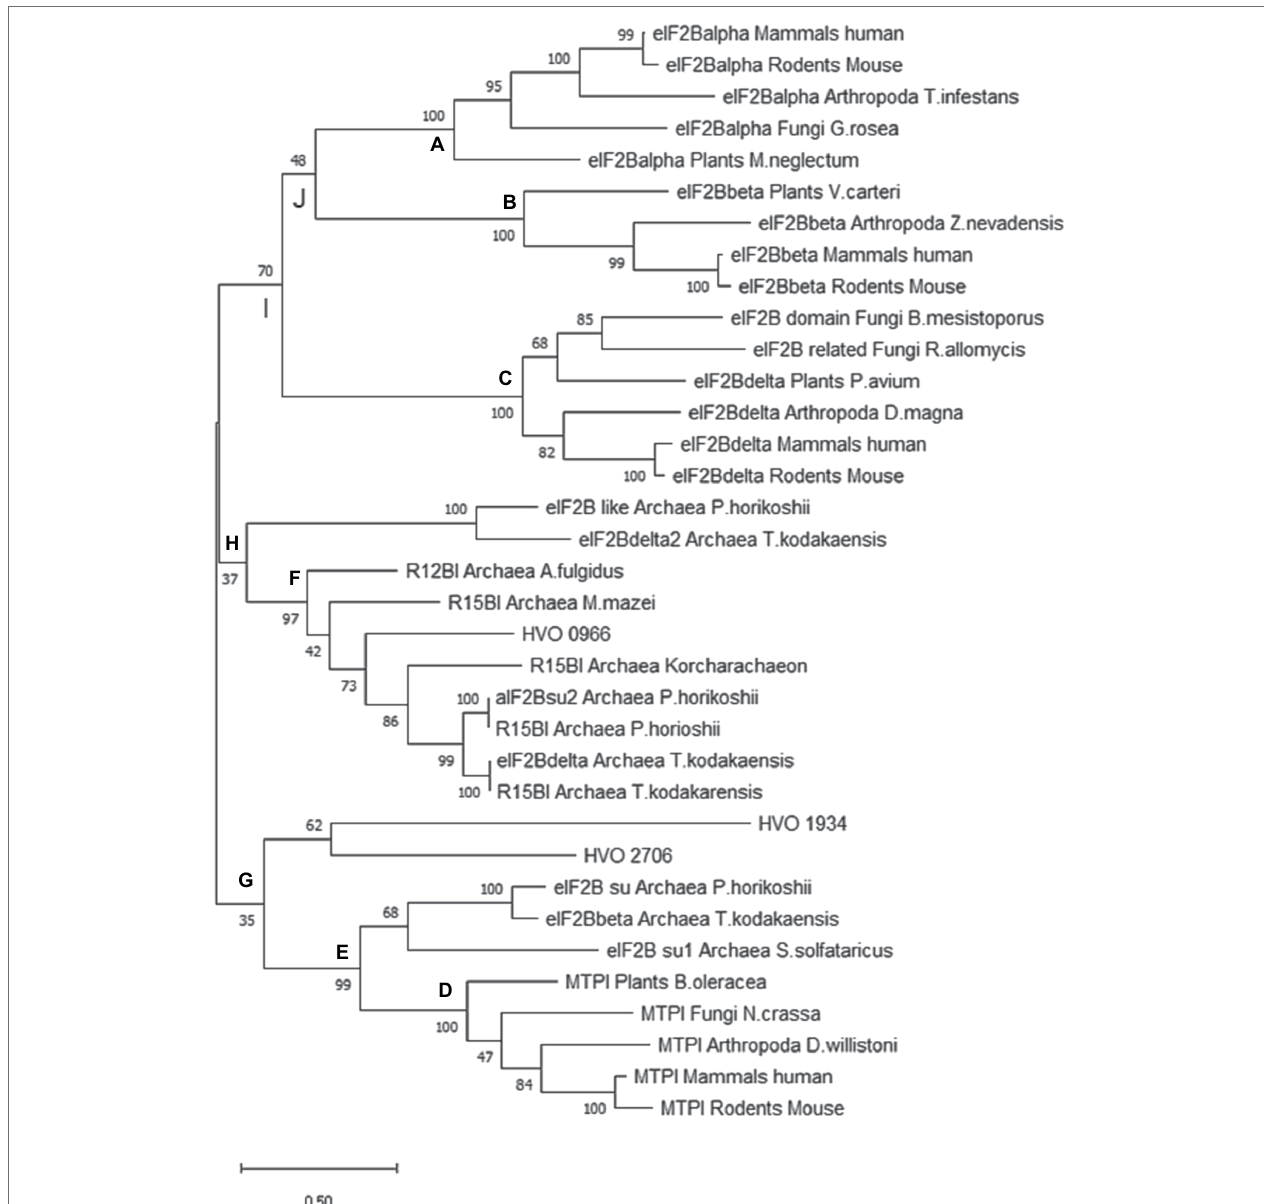
FIGURE 6 | Phylogenetic tree of selected archaeal and eukaryotic proteins of the a/eIF2B superfamily. Criteria for selection of the 35 proteins are explained in the text. A maximum likelihood (ML) tree was calculated using the program Mega X (Kumar et al., 2018). 1,000 bootstrap replications were performed, and the bootstrap values are shown at each node (%). Specific nodes of interest were labeled with A to G to facilitate the discussion (see